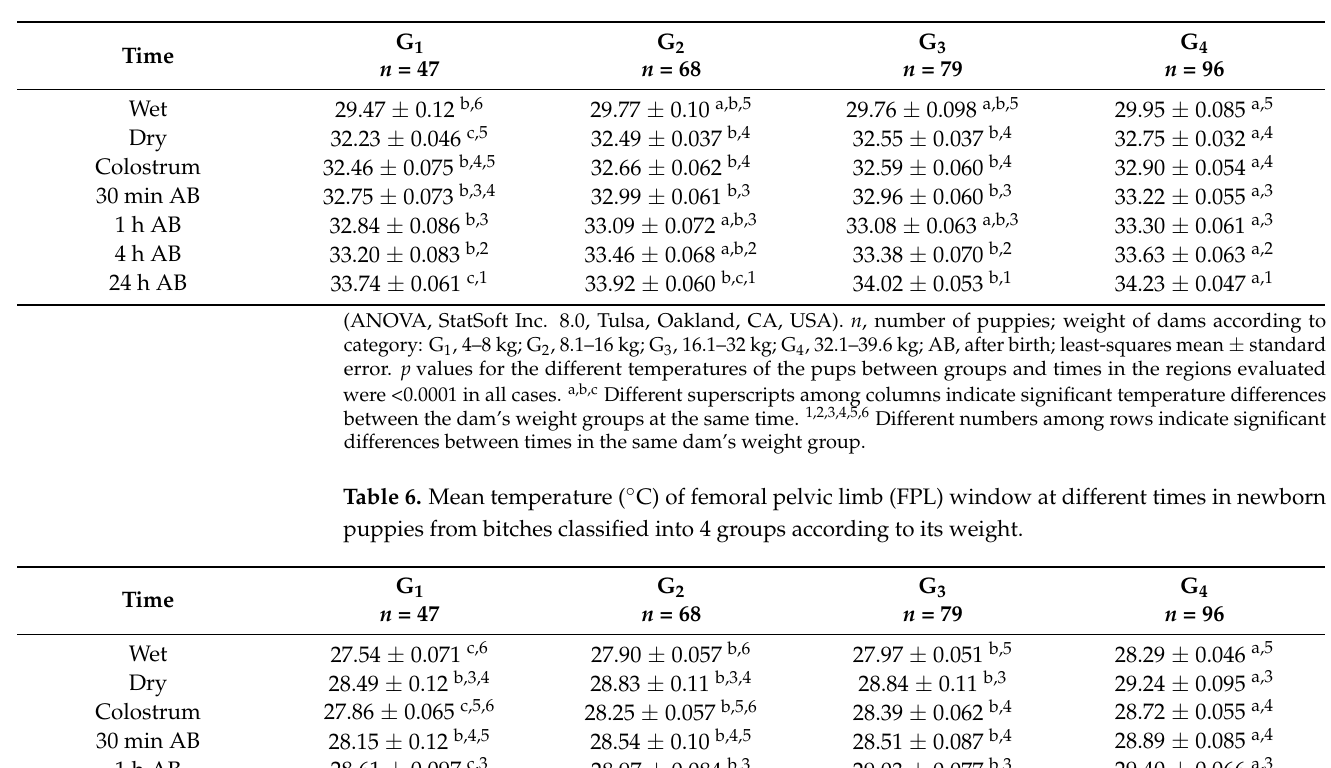
Table 5. Mean temperature ( ◦ C) of abdominal (A) window at different times in newborn puppies from bitches classified into 4 groups according to its weight.